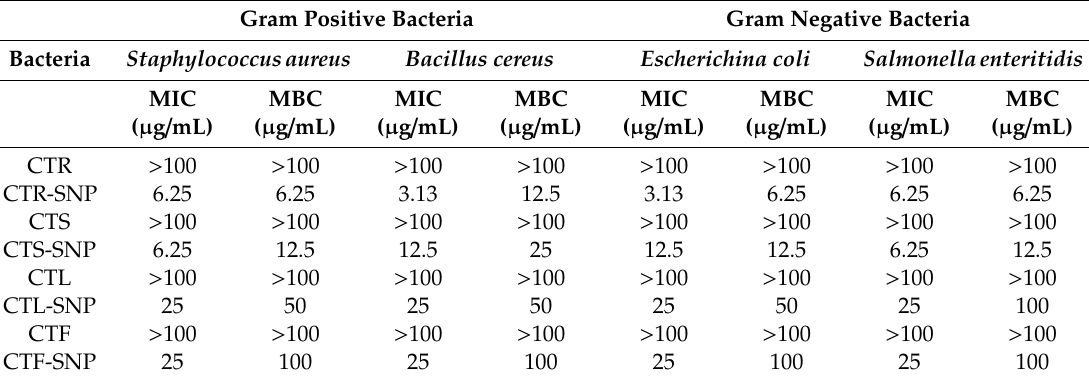
Figure 5. UV-visible spectrum of ( A ) MB, ( B ) MO, ( C ) RB, and ( D ) RB5 on addition of CTR, CTS, CTL, and CTF-SNPs. Table 1. Minimum inhibitory concentration (MIC) and Minimum bactericidal concentration (MBC) of CTR, CTS, CTL and